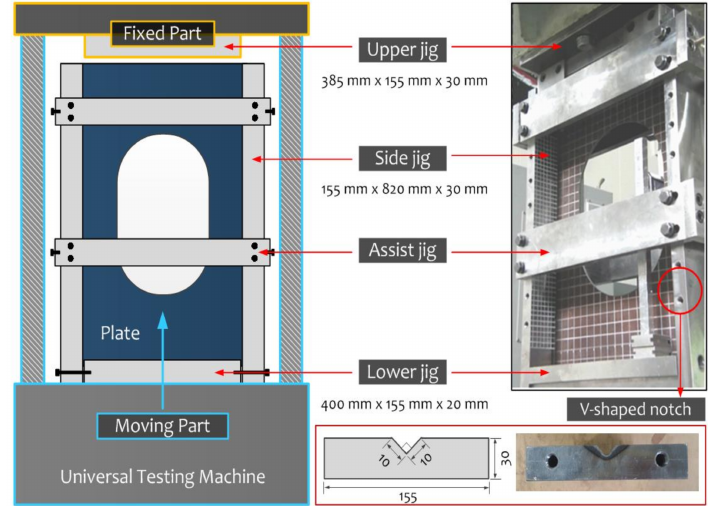
Figure 2. Experimental jigs and overall picture of test set-up.